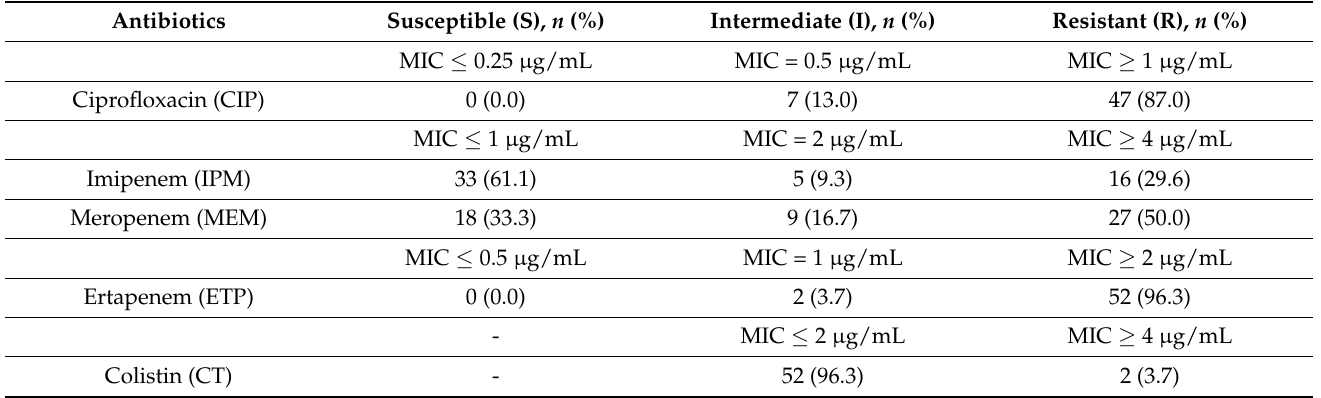
Figure 1. Isolation of NC-CRKP (clinical and screening) among hospitalised patients in UMMC, Malaysia from 2013 to October 2019. Table 1. Interpretive MIC categories of all 54 NC-CRKP via broth microdilution method. Antibiotics Susceptible (S), n